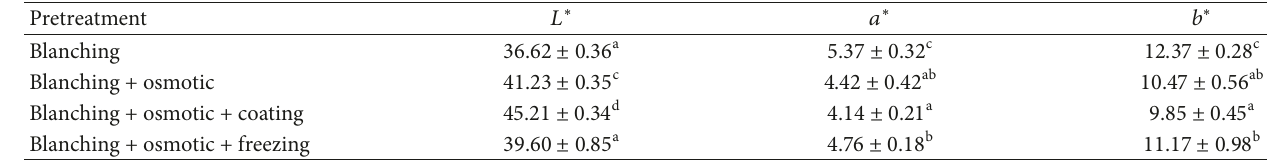
Table 1: The color value of shiitake mushroom chips for different pretreatments.